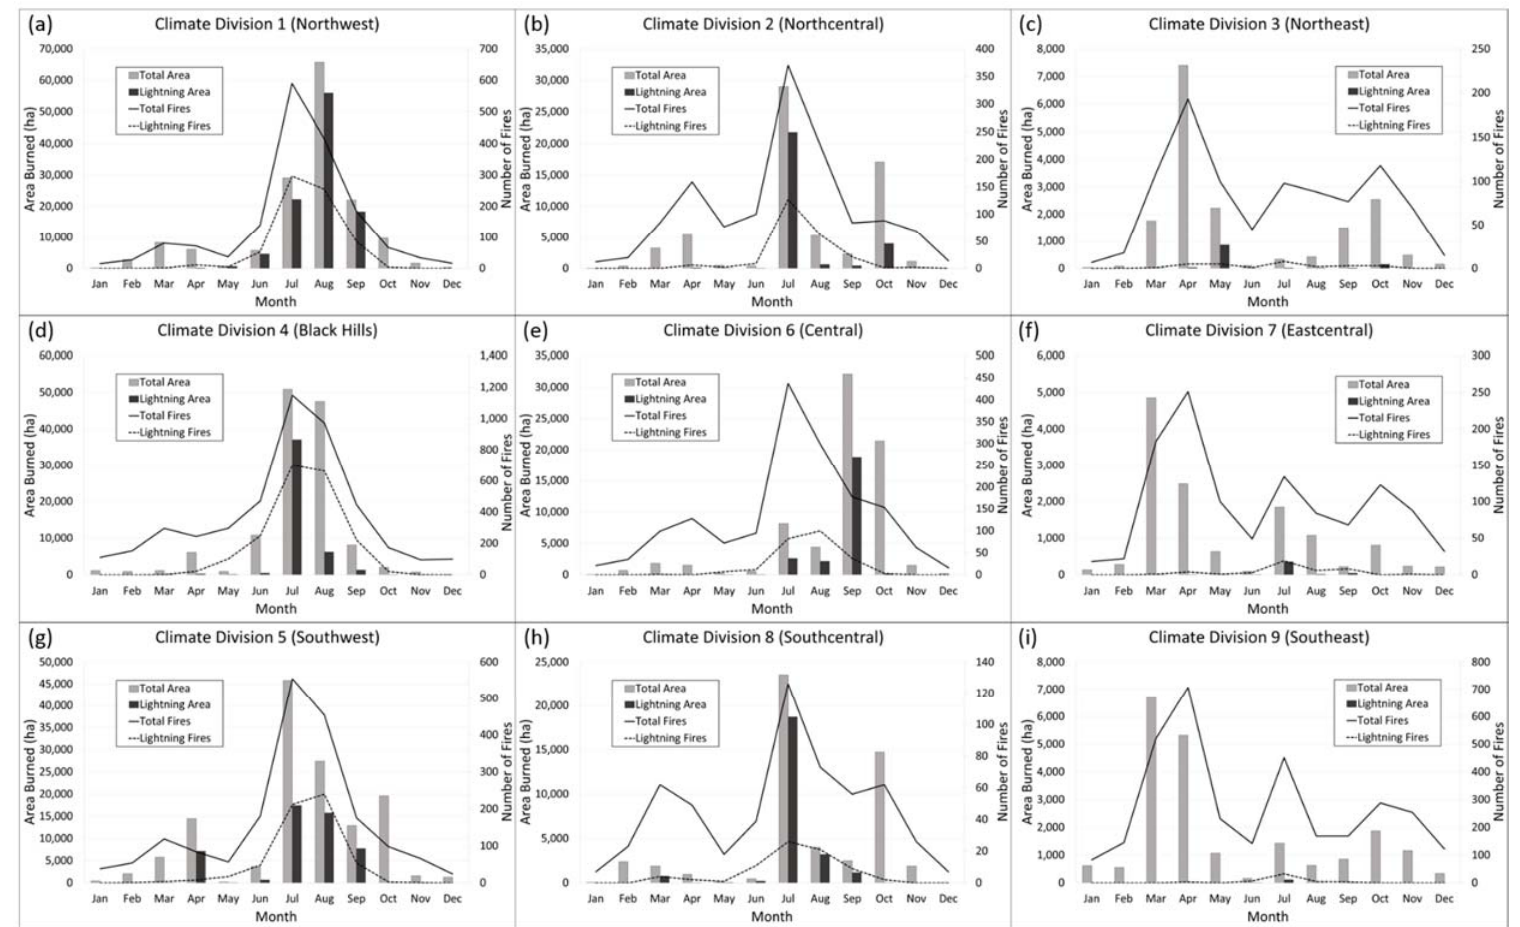
Figure 3. Monthly total hectares burned and number of fire starts for South Dakota: ( a ) Climate Division 1 (Northwest); ( b ) Climate Division 2 (Northcentral); ( c ) Climate Division 3 (Northeast); ( d ) Climate Division 4 (Black Hills); ( e ) Climate Division 6 (Central); ( f ) Climate Division 7 (Eastcentral); ( g ) Climate Division 5 (Southwest); ( h ) Climate Division 8 (Southcentral); ( i ) Climate Division 9 (Southeast). Note: the scale of the vertical axes differs between panels.